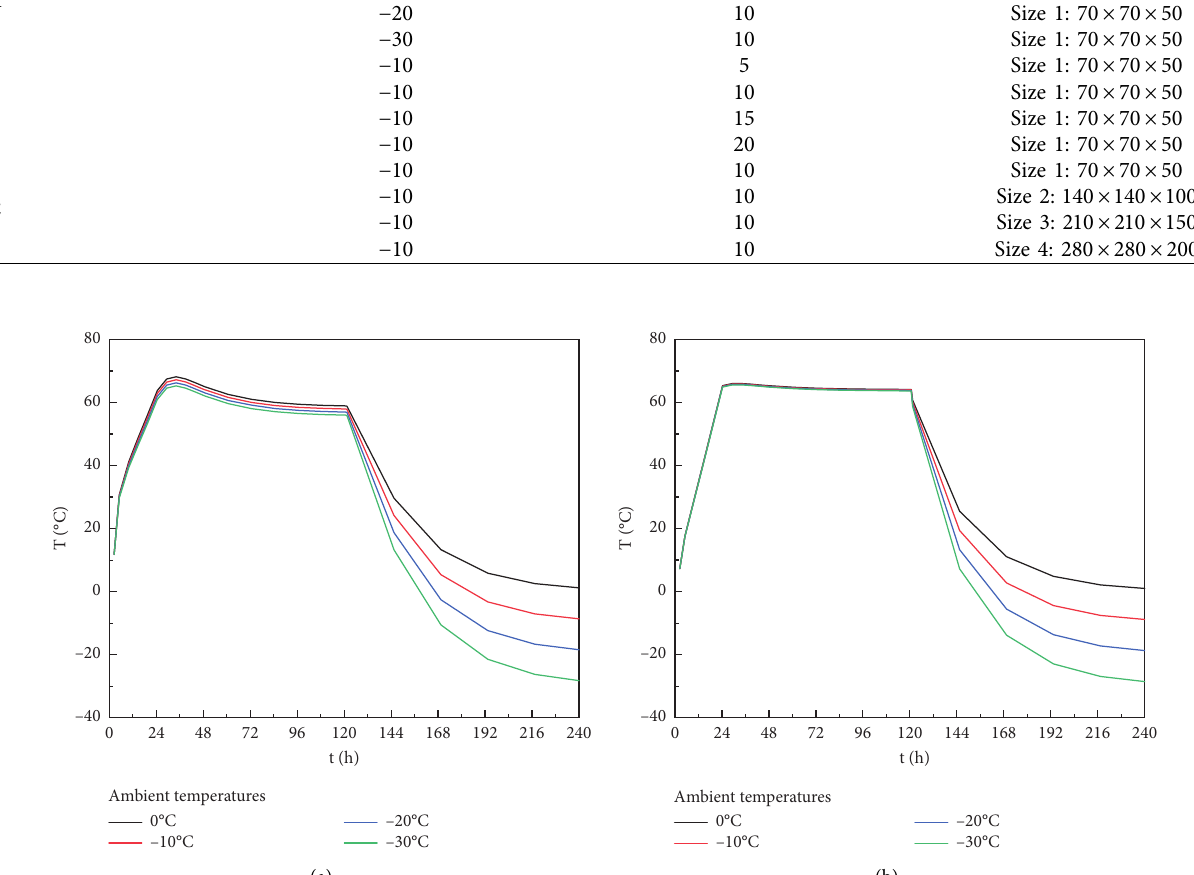
Figure 9: Change in concrete temperature over time according to ambient temperature at (a) T3 and (b)